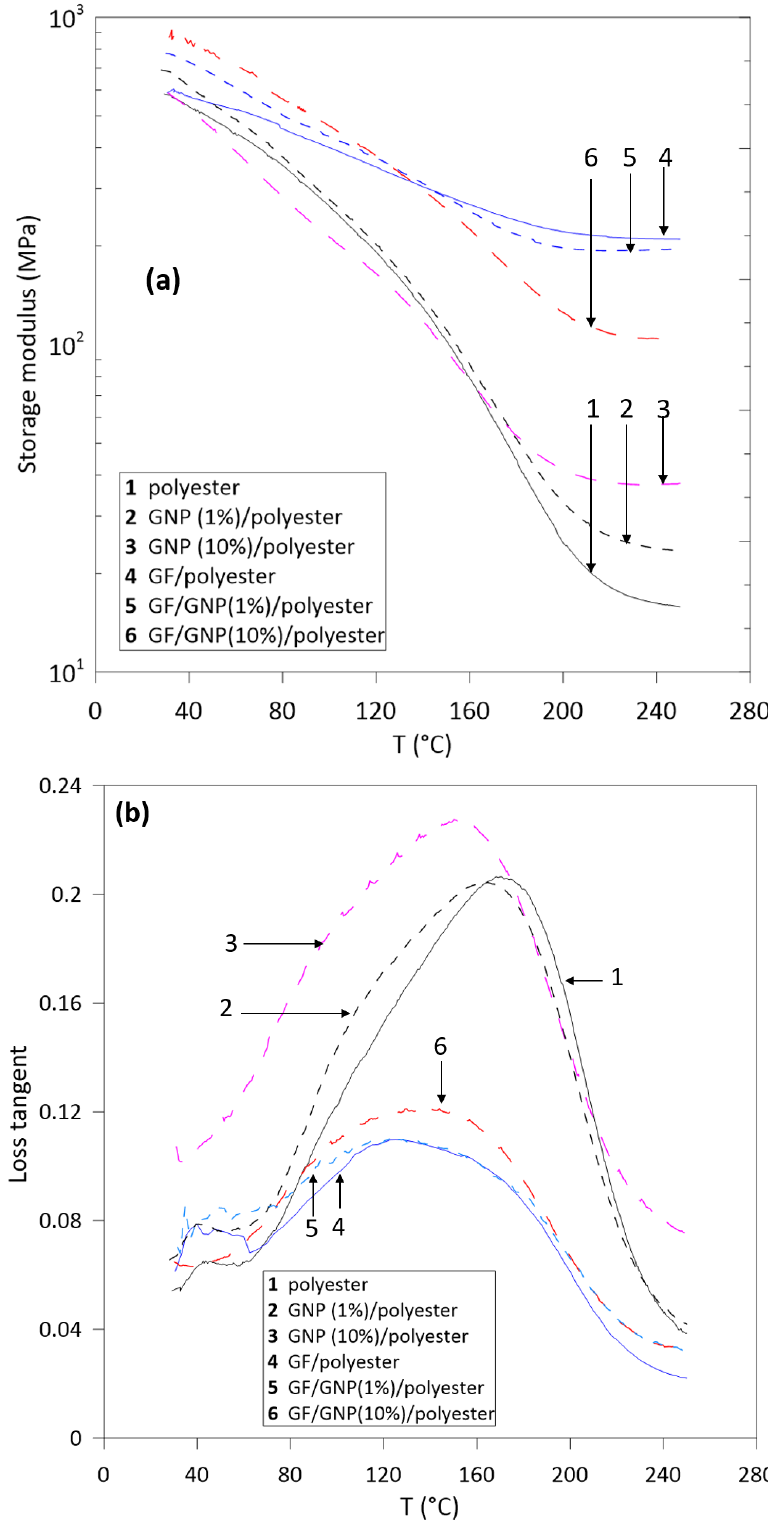
Figure 5. ( a ) Storage modulus and ( b ) loss tangent values of the glass fiber/polyester and GNPs (graphene nanoplatelets)/glass fiber/polyester composites. Figure 5b shows that the temperature corresponding to the tan δ maximum peak did not change significantly with GNP loading. Due to the relatively broad α -relaxation temperature range of these composites in mechanical loss spectra, it would be inappropriate to choose the temperature correspond ing to the tan δ peak as the T g value. As well as the α -relaxation peak around T g , one can see that the β relaxation peak occurs in the temperature range of 30 °C–50 °C. This peak could be associated with the high- frequency β relaxation in dielectric spectra, although it should be considered that there are significant differences between the relaxation behavior determined from dielectric and dynamic mechanical data [17]. As shown in Figure 5b, for the composites containing high amounts of GNP, β relax ation appears to be absent; instead, an excess contribution to the tail of the α relaxation is observed. To study the interfacial adhesion between the components and matrix material, SEM was performed. The fracture surface of the non-reinforced polyester system displays a relatively smooth surface indicating a brittle-type failure (Figure 6a,b). It can be seen that CaCO 3 and GNP are both properly dispersed in the resin. The atomic composition of the polyester suspension is confirmed by EDX (Figure 7). A complete uniformity is required, otherwise areas of non-interaction can occur, decreasing the strength of the composite. To investigate the adhesion between GF, GNP and the matrix, the morphologies of the GNP/GF/polyester composites are shown in Figure 6c,d. According